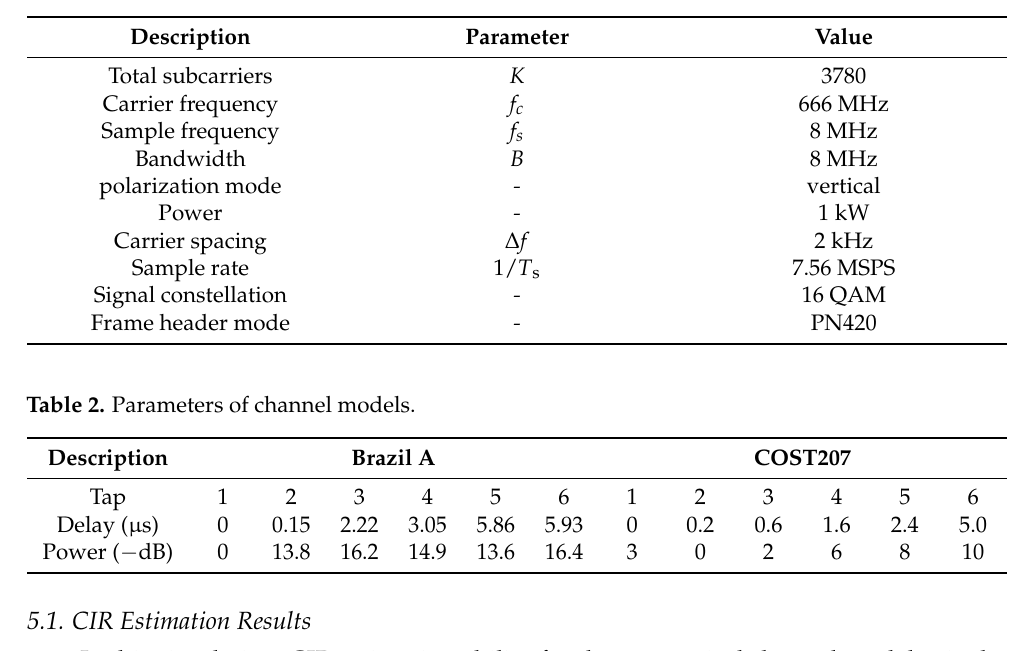
Table 1. Parameters of PBR system.